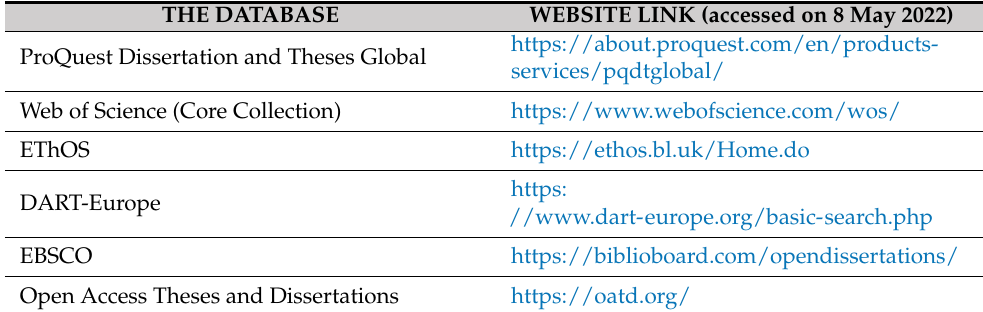
Table 1. Database names and